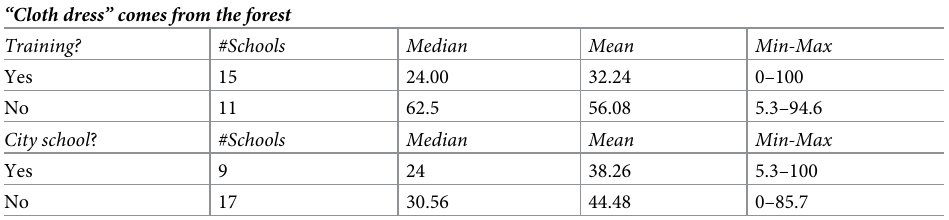
No significant differences were found.